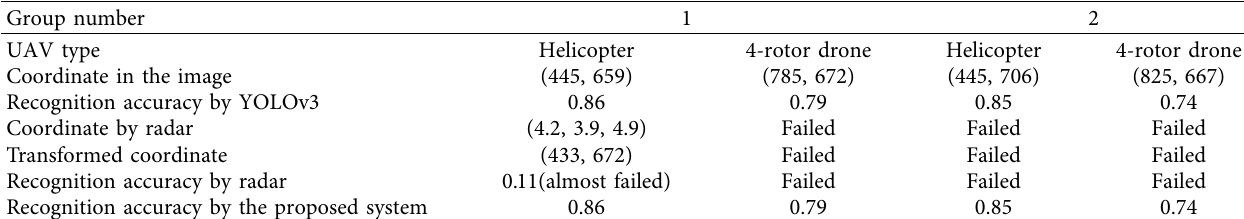
Table 3: Experiment 1: identification of UAVs by the information fusion model in a good light and long-distance scenario. Group